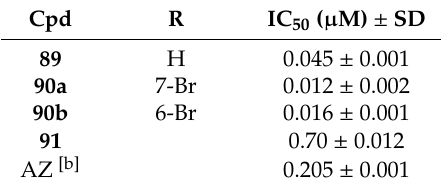
Figure 18. Structure of neopeltolide (88) and representative simplified analogs ( 89 , 90a , b and 91 ). Table 10. IC 50 ( µ M) value of compounds 89 – 91 against porcine SCR. [a]